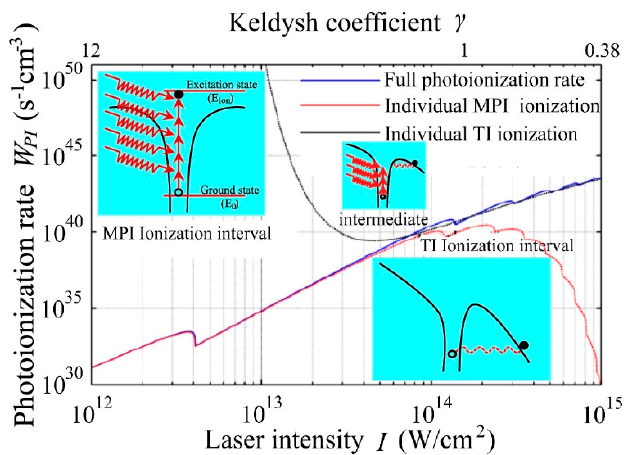
Figure 4. Correlations between incident laser intensity I and PI rate W PI with the consideration of full Keldysh’s ionization, individual multiphoton ionization (MPI) and tunneling ionization (TI) ionizations under 800 nm lasers irradiation [29].